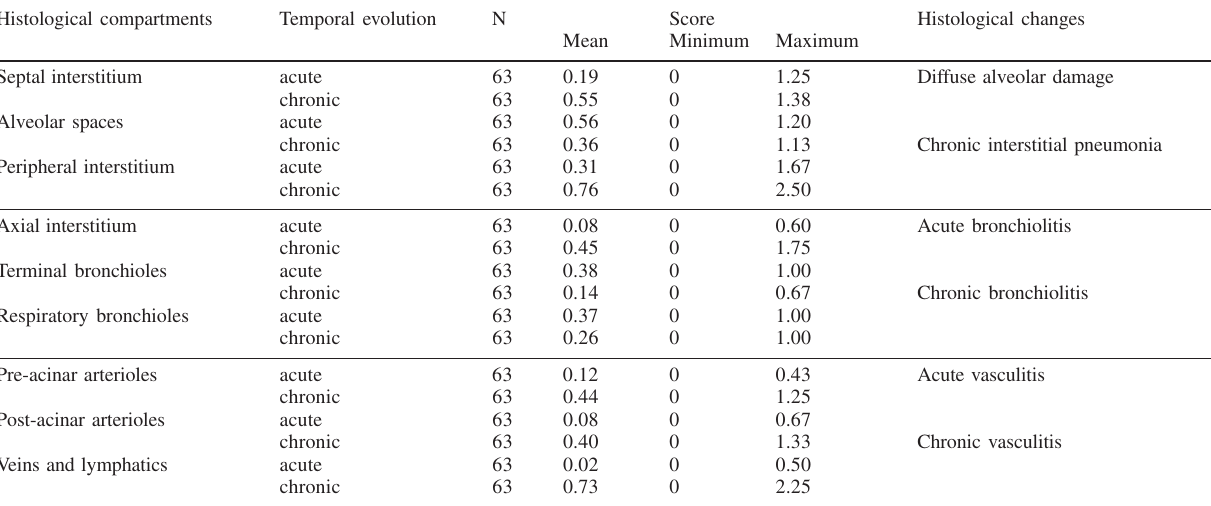
Table 2 - Mean, maximum, and minimum values of the acute and chronic histological score obtained by semiquantitative assessment